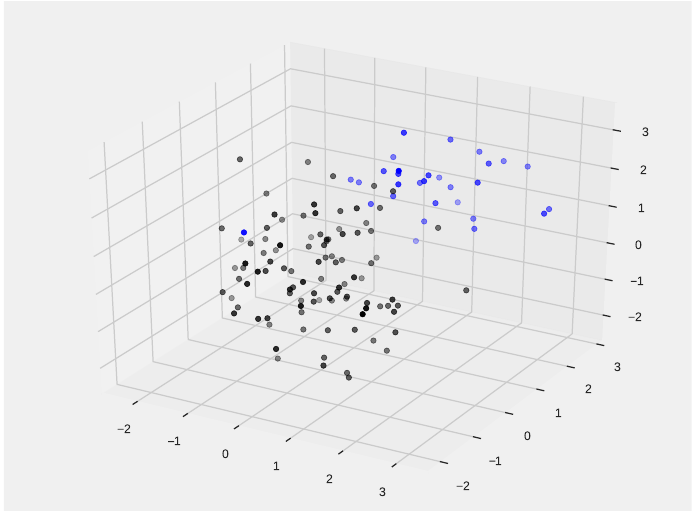
Figure 4. Distribution of points in the synthetically generated